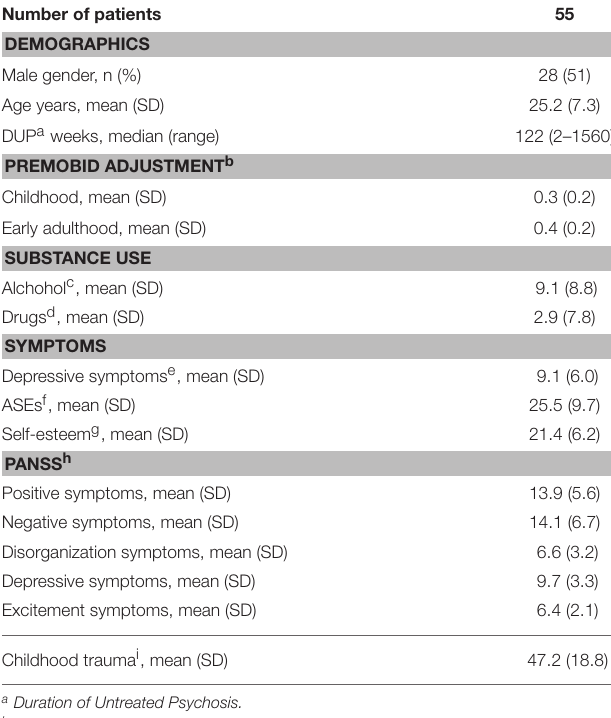
TABLE 1 | Demographic and clinical